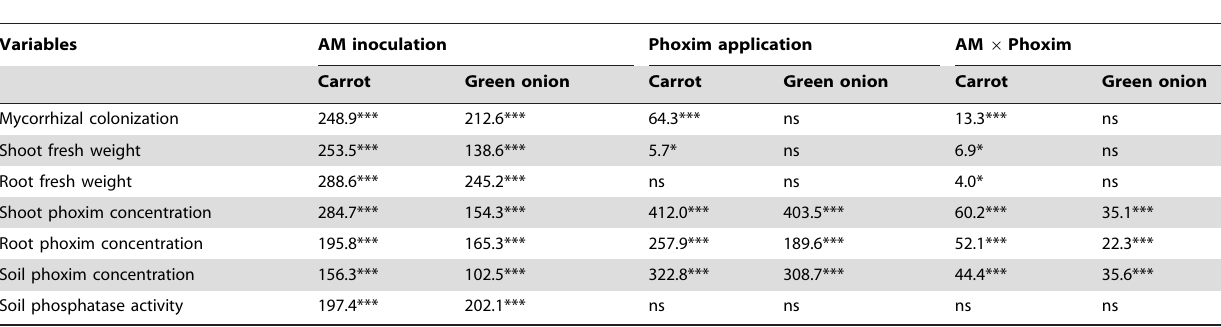
Table 1. Significance levels ( F -values) of treatments and treatment interactions on measured variables on a two-way ANOVA